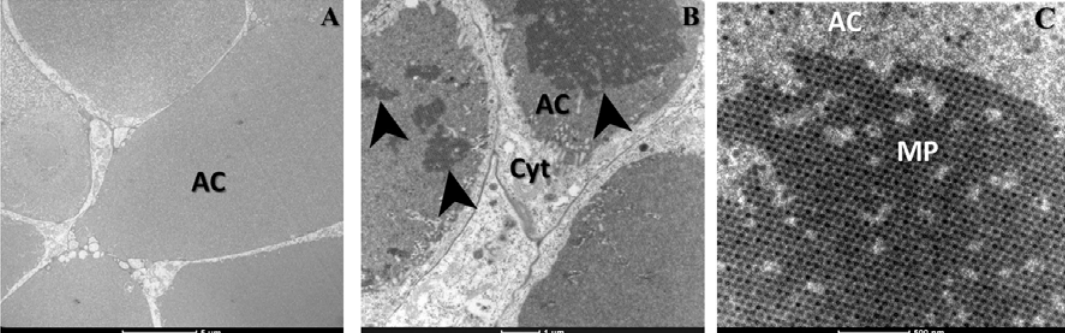
Figure 3. CHIKV stored in the apical cavities of salivary glands acinar cells of Ae. albopictus . ( A ) non-infected apical cavities; ( B , C ) apical cavities infected with CHIKV; ( B ) CHIK virions aggregations (black arrows); ( C ) detail (zoom) of one aggregation of CHIK mature virions (MP) whose envelope is clearly observed. AC: apical cavity. Cyt: cytoplasm. Images were captured using a FEI Tecnai Biotwin transmission electron microscope.